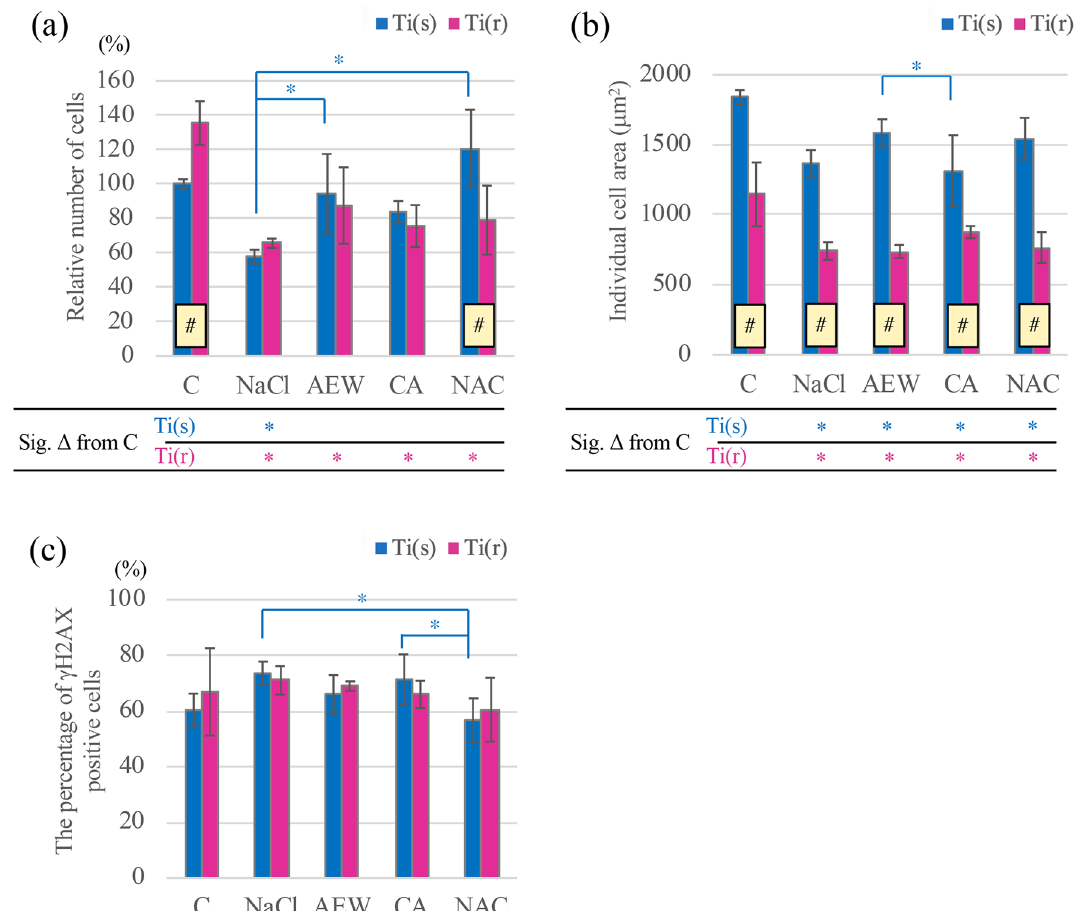
Figure 6. ( a ) Relative number of cells attached to control and to treated titanium discs. ( b ) Individual cell area (actin-stained) on titanium discs by group. ( c ) Percentage of γH2AX-positive cells on titanium discs by group. Mean values and ± SD; *indicates a significant difference ( p < 0.05) between the (sub)groups and # indicates a significant difference ( p < 0.05) between disc categories. All p values based on multiple regression analysis. Six discs (3 Ti(s) and 3 Ti(r)) per group, total n = 30